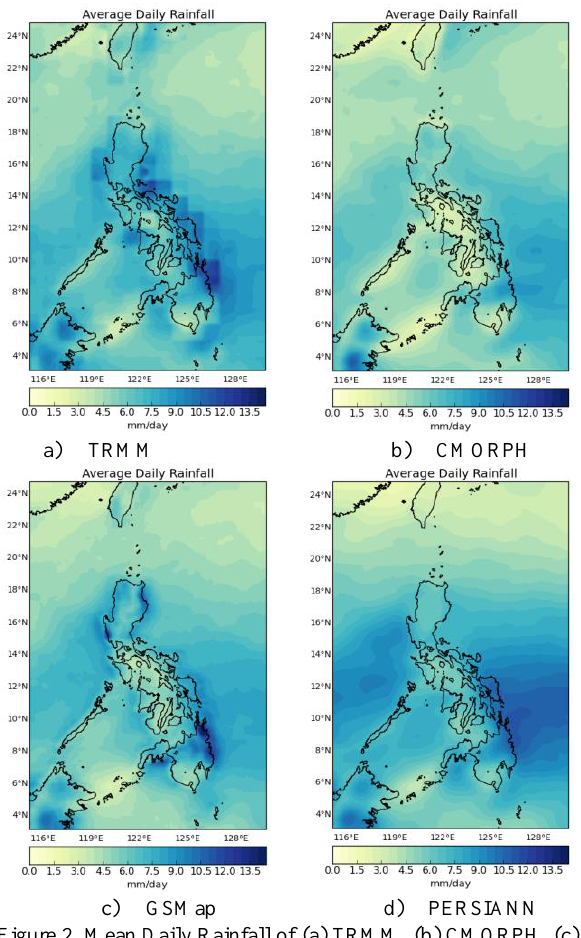
Figure 2. Mean Daily Rainfall of (a) TRMM, (b) CMORPH, (c) GSMAP and (d) PERSIANN satellite precipitation products.